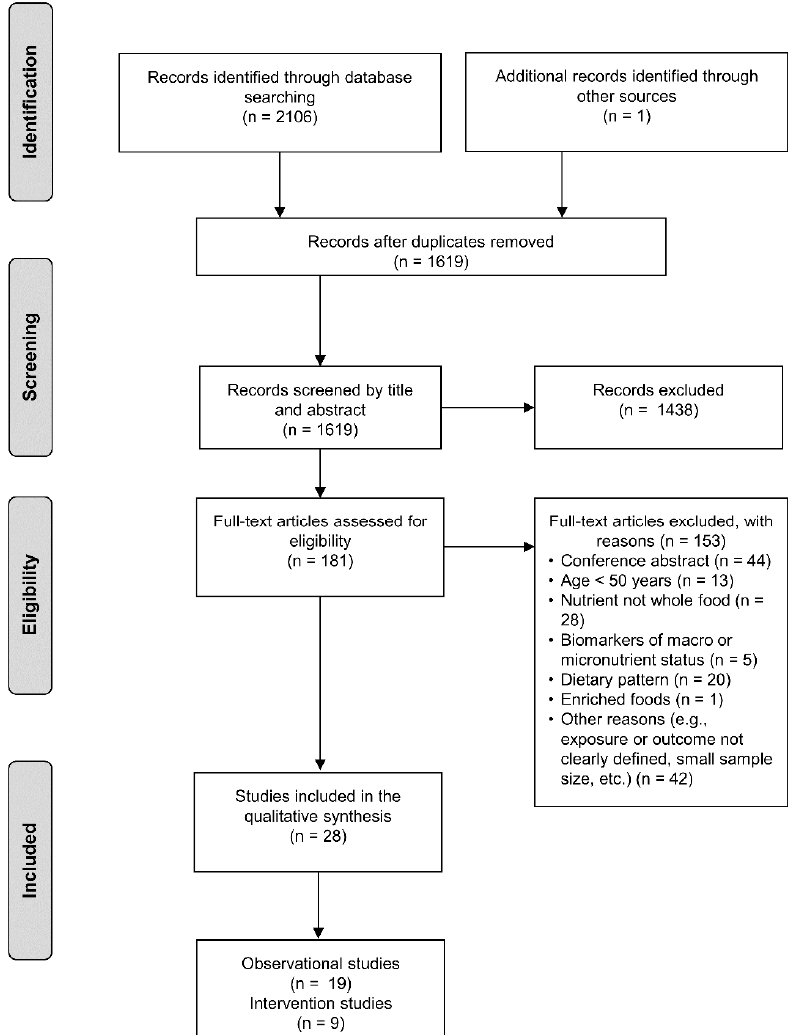
Figure 1. PRISMA flow diagram of the selected studies. PRISMA, Preferred Reporting Items for Systematic Reviews and Meta-Analyses.